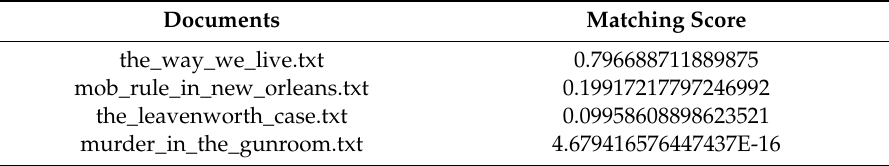
Table A10. Top Docs for TermQuery: prison, kill, and